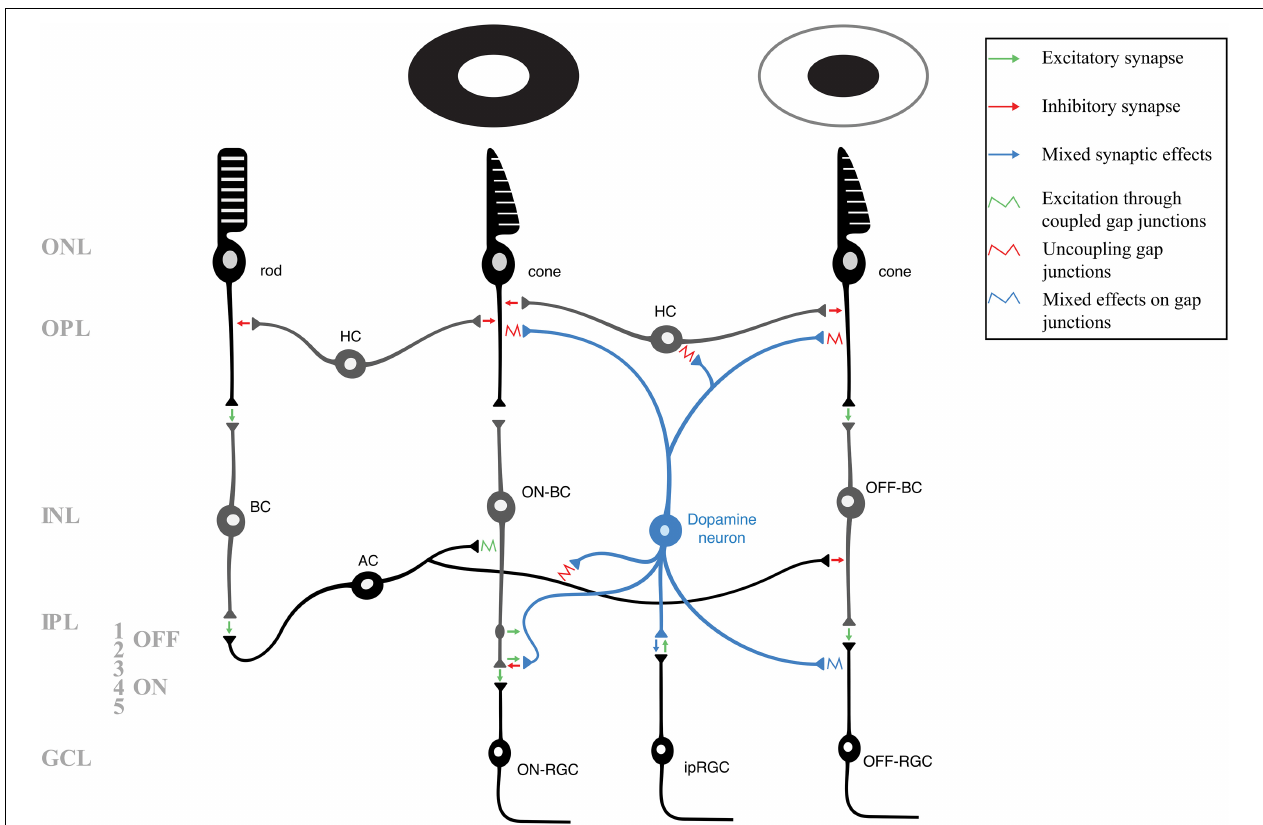
FIGURE 1 | A schematic of the layers and neuronal circuitry of the retina, including the pathways of rods, cones that respond to light (middle photoreceptor), and cones that respond to dark (right photoreceptor). For clarity and simplicity, many neurons and synapses have been excluded. The various modulatory mechanisms of retinal dopamine neurons (blue) affect nearly every retinal neuron to allow the retina to adapt to photopic conditions. Green arrows indicate excitatory (glutamatergic) synapses, red arrows indicate inhibitory (GABAergic/glycinergic) synapses, and blue arrows indicate mixed synaptic effects. A potential excitatory en passant synapse (between ON-bipolar cell axon and dopamine neuron) is shown in strata 1 of the inner plexiform layer. Retinal gap junctions, which are also targets of various dopaminergic and other modulatory mechanisms, are represented by squiggles. The green squiggle indicates depolarization via heterotypic coupling, red squiggles indicate dopaminergic uncoupling of gap junctions, and blue squiggle indicates mixed effects of dopamine on the coupling or uncoupling of gap junctions. AC, amacrine cell; BC, bipolar cell (including those depolrized – ON – and inhibited – OFF – by light); GCL, ganglion cell layer; HC, horizontal cell; INL, inner nuclear layer; IPL, inner plexiform layer (including the OFF – 1 and 2 – and ON – 3, 4, and 5 – strata); ipRGC, intrinsically photosensitive retinal ganglion cell; ONL, outer nuclear layer; OPL, outer plexiform layer; RGC, retinal ganglion cell (including the ON and